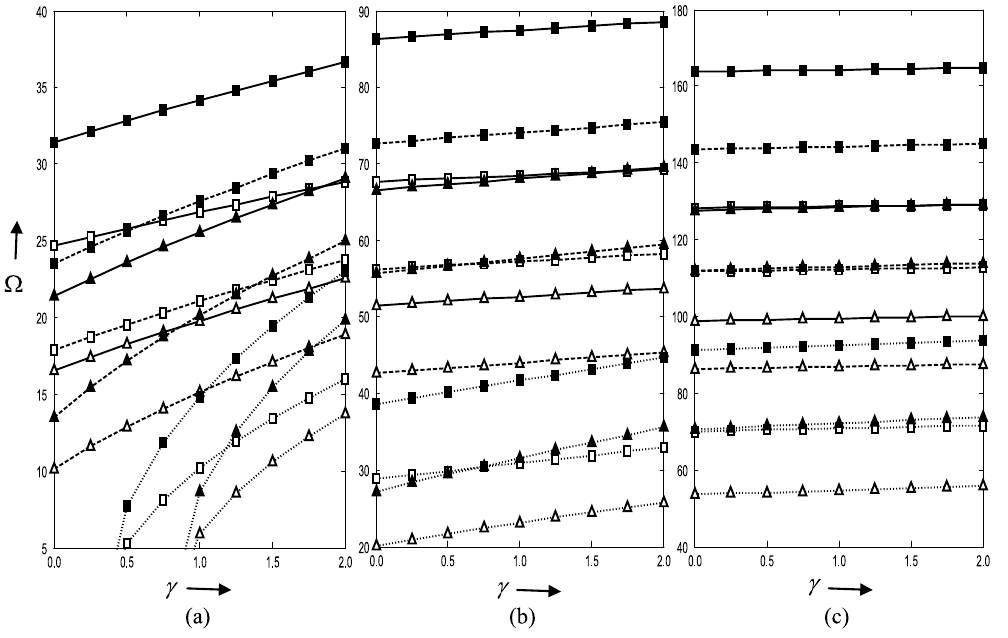
Fig. 5. Frequency parameter Ω for (a) first mode (b) second mode (c) third mode. _____, C-C; - - - - -, C-S; ......, C-F; N ∗ 0 = 30, a/b = 1 ; (cid:3) , μ = 0 . 5 , β = 0 . 5 ; (cid:5) , μ = 0 . 5 , β = − 0 . 5 ; (cid:4) , μ = − 0 . 5 , β = 0 . 5 ; (cid:6) , μ = − 0 . 5 , β = − 0 . 5